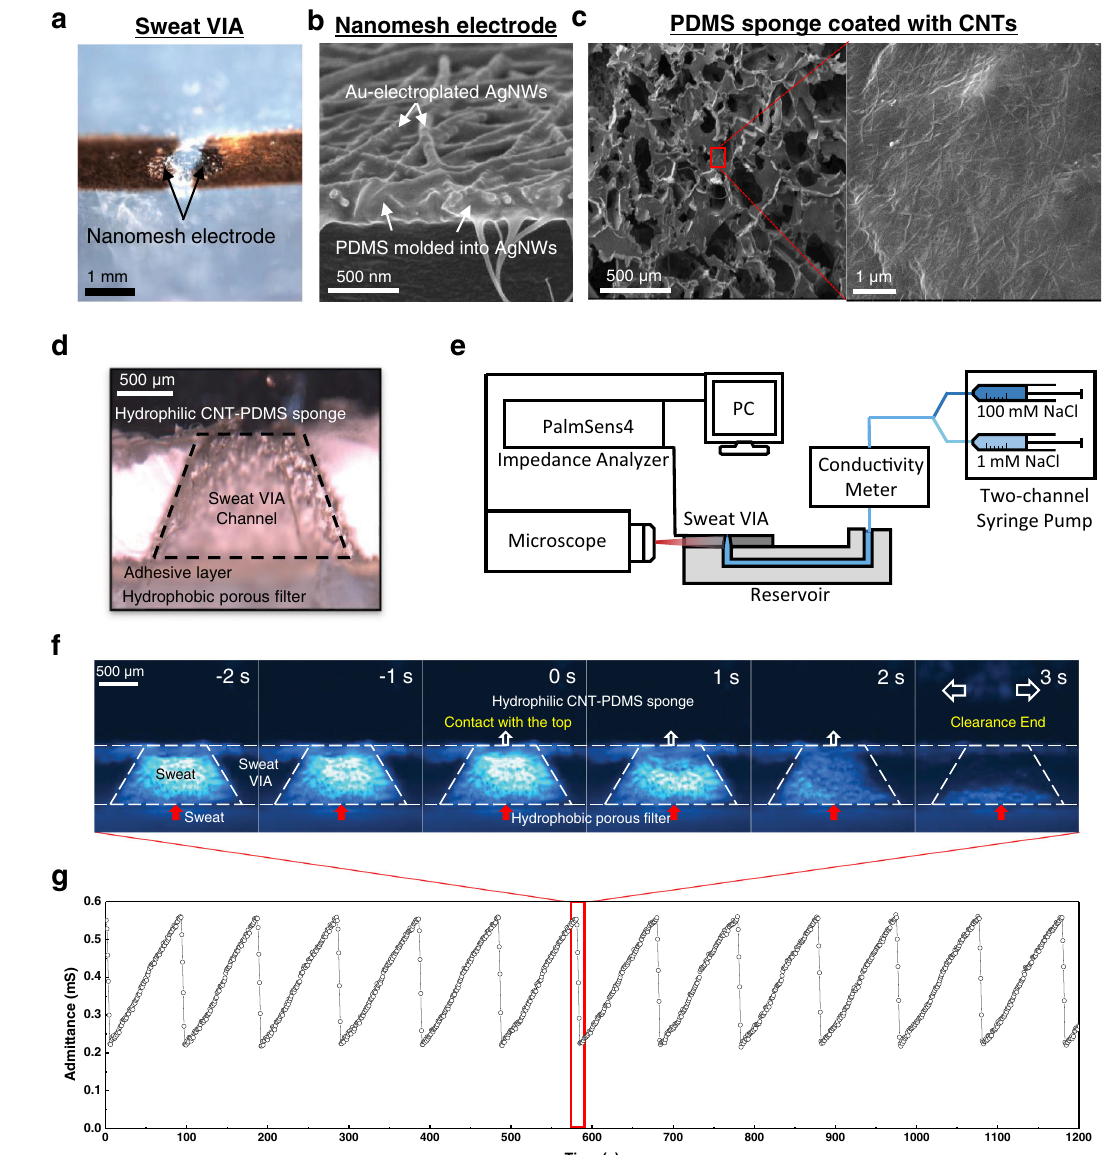
Fig. 3 | Characteristics of the sweat VIA sensor. a Photograph of the VIA channel andnanomeshelectrode.Scanningelectronmicroscopeimagesof b thenanomesh electrode and c CNT-PDMS sponge. d Side-view optical image of the assembled sweat VIA sensor. e Experimental setup for visualizing sweat fl ow in the sweat VIA sensor and measuring admittance. f Fluorescence micrographs showing clearance